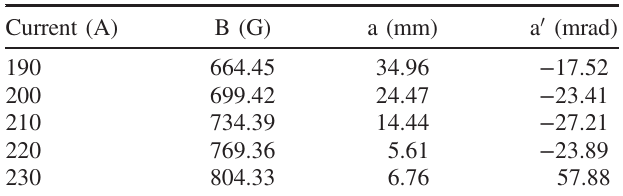
TABLE I. First transport magnet current, peak axial field, and